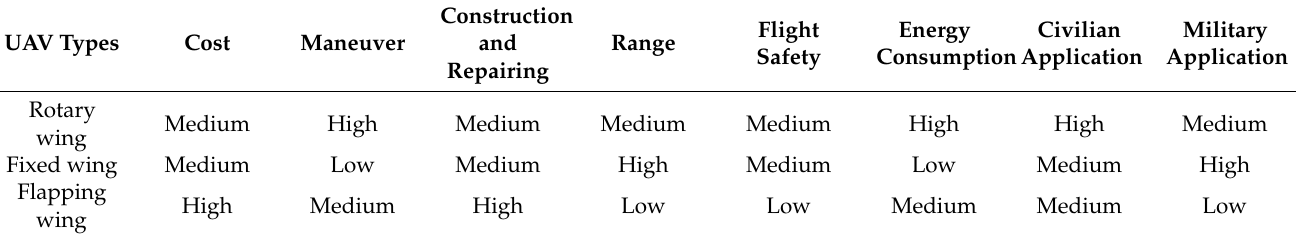
figuration, UAVs can be divided into three categories: fixed wing, rotary wing, and flapping wing. The advantages and disadvantages of these UAVs are shown in Table 1. Table 1. Comparison between UAV types